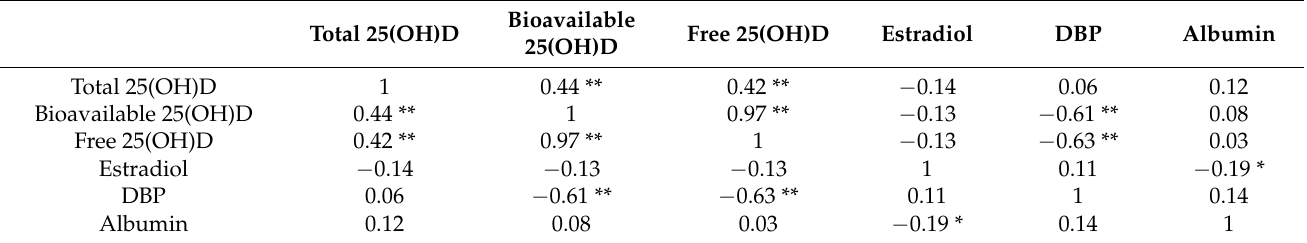
Table 2. Pearson’s correlation coefficients (r) of blood biomarkers in healthy women from the Central Slovenian region aged between 44 and 65 years who were included in the study carried out between 1 March 2021 and 31 May 2021 ( n = 176).